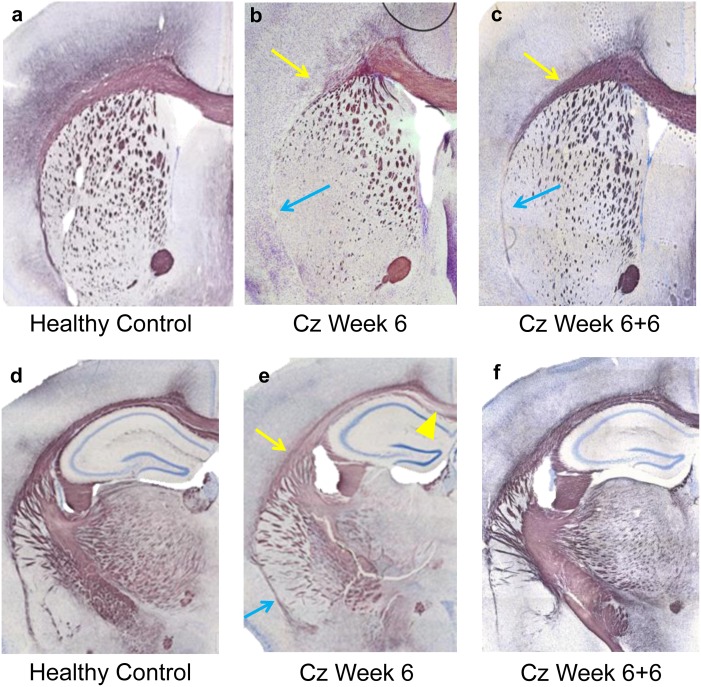
Black Gold II Stain for Myelin in Caudal and Rostral CC.BGII stains roughly corresponding to gCC (a-c) and sCC (d-f) ROIs in Fig 2. Age-matched control with normal myelinated lat-CC/EC (a); substantial demyelination in rostral lat-CC/EC (arrows) after 6 weeks Cz (b); lat-CC/EC partially recovered after 6 weeks on regular chow (c). Reduction in myelinated fibers in caudoputamen is observed both at Week 6 and Week 6+6 compared to control. Stark demyelination is evident in the caudal med-CC (e, arrowhead), while lat-CC/EC (arrow) is only mildly demyelinated after 6 weeks cuprizone (e) compared to control (d). Remyelination in lat-CC/EC and med-CC is substantial yet incomplete after 6 weeks recovery (f). Blue arrows indicate demyelination in EC beyond the extents of MRI-visible lat-CC/EC.